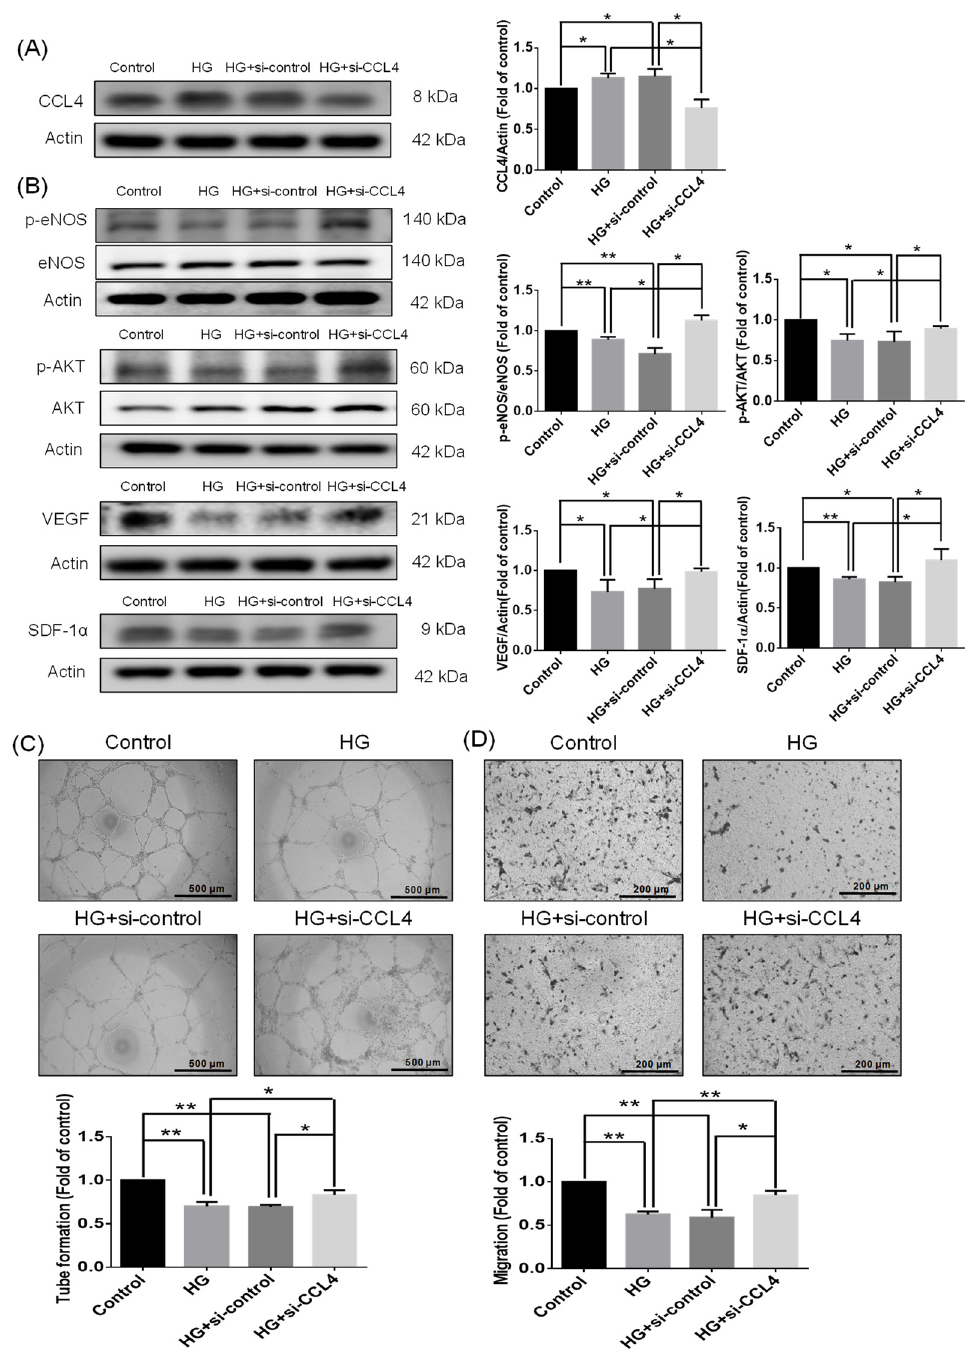
Figure 1. CCL4 inhibition by siRNA recovered functions of high-glucose-impaired HDMECs with increased angiogenic protein expressions. Western blotting and statistical analyses of CCL4 (( A ); n = 3), p-AKT, p-eNOS, VEGF, and SDF-1 α . The angiogenic proteins were reversed after the administration of siCCL4 (( B ); n = 3). Tube formation ability and quantitative analysis of HDMECs; the images were captured using a ( × 40) microscope. The tube formation ability was improved after the administration of siCCL4 (( C ); n = 3). Migration ability and quantitative analysis of HDMECs; the images were captured using a ( × 100) microscope. The migration ability was improved after the administration of siCCL4 (( D ); n = 3). HG represents high glucose. * p < 0.05, ** p < 0.01.